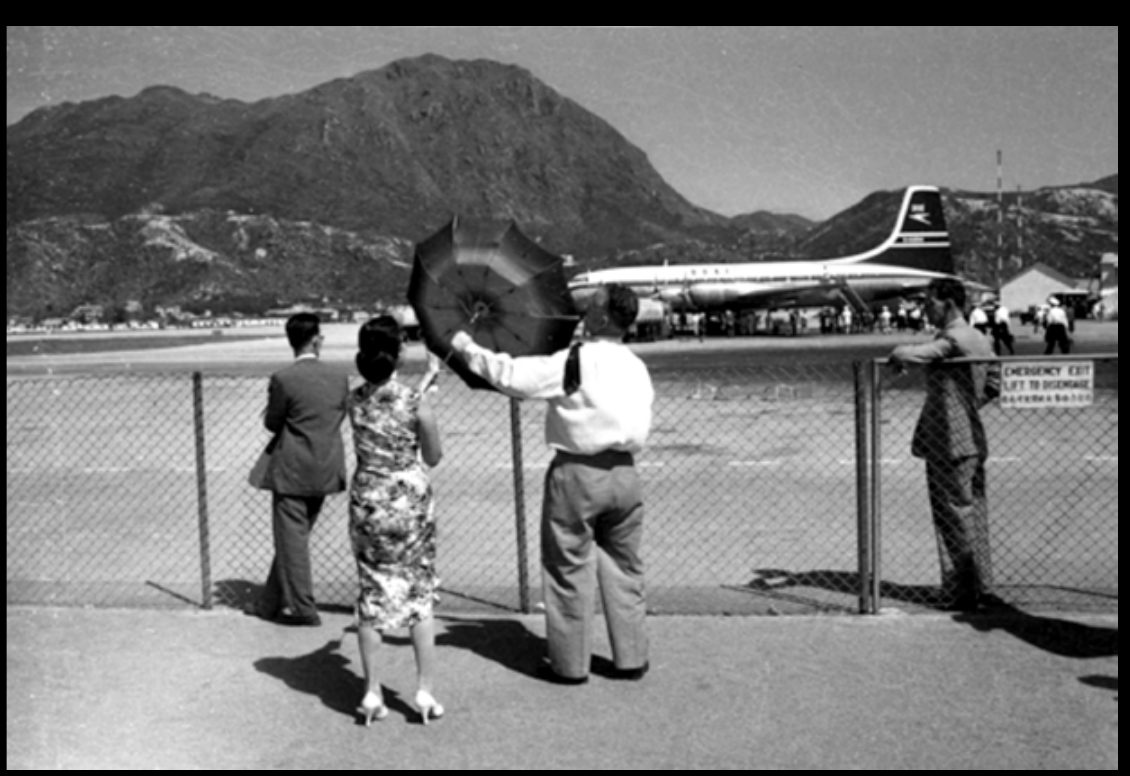
Figure 11a: Nick Howard, A Flipped Umbrella, Kai Tak Airport, Kowloon,